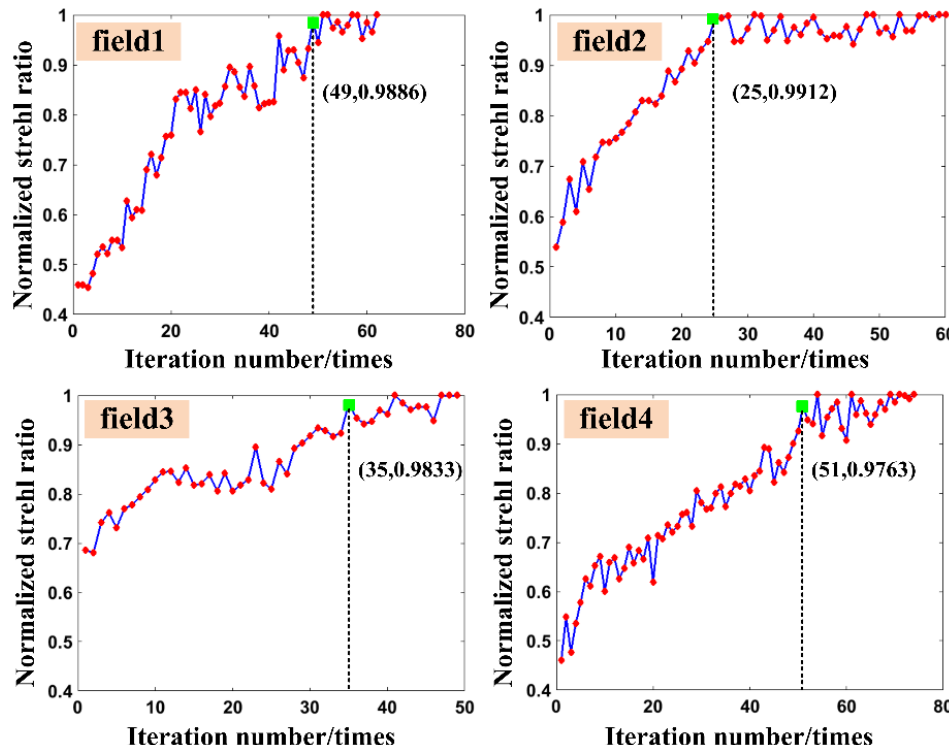
Figure 7. Convergence curves corresponding to different fields of view. The misaligned images and corrected images are shown in Figure 8.